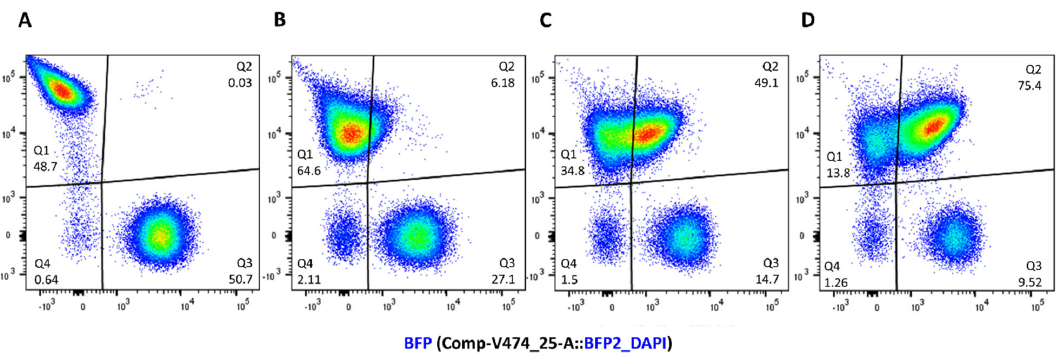
Figure 4. Flow cytometry results for time course filter mating between J53Az + p_mCherry-stable recipient and UB5201Rf + pConj_blue-strong donor strains over 6 h. Bacterial cells recovered from conjugation mixes at time points 0 h ( A ), 2 h ( B ), 4 h ( C ) and 6 h ( D ) were analyzed by flow cytometry. Regions Q1, Q2, and Q3 on the red (mCherry2) versus blue (BFP) fluorescence bivariate plots correspond to the recipients (mCherry + ebfp2 − ), the transconjugants (mCherry + ebfp2 + ) and the donors (mCherry − ebfp2 + ) populations, respectively.